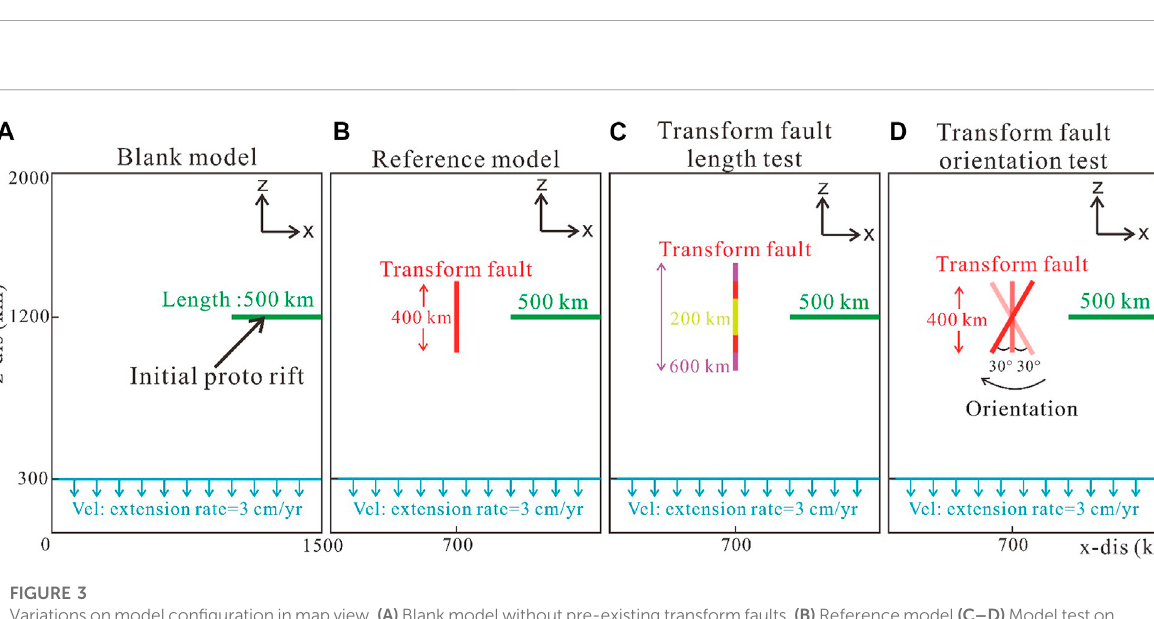
FIGURE 2 Numericalmodelsetup. (A) Initialmodelcon fi guration.Bluearrowsdisplaytheinitialvelocity fi eldinthemodeldomain. (B) Enlargedviewofthe proto-rifting zone. Color code of the lithology: 1-upper continental crust, 2-lower continental crust, three- lithospheric mantle, 4-asthenospheric mantle, 5-proto rifting zone. (C) Initial vertical distribution of temperature and lithospheric strength.